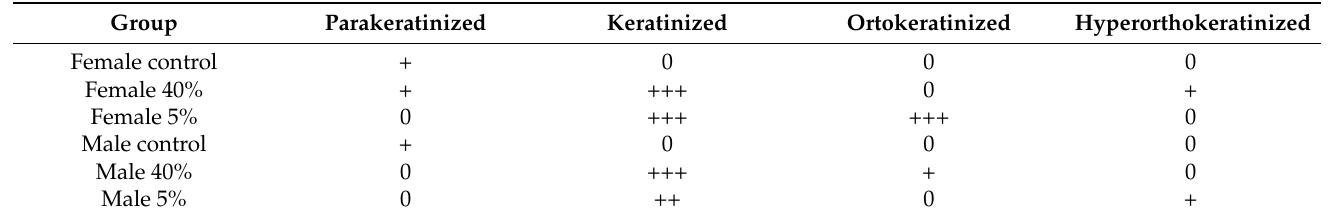
Table 1. Type of surface layer in the cheek mucosa after the consumption of 3 months of weekend alcohol consumption at 5% and 40% in both females and males.